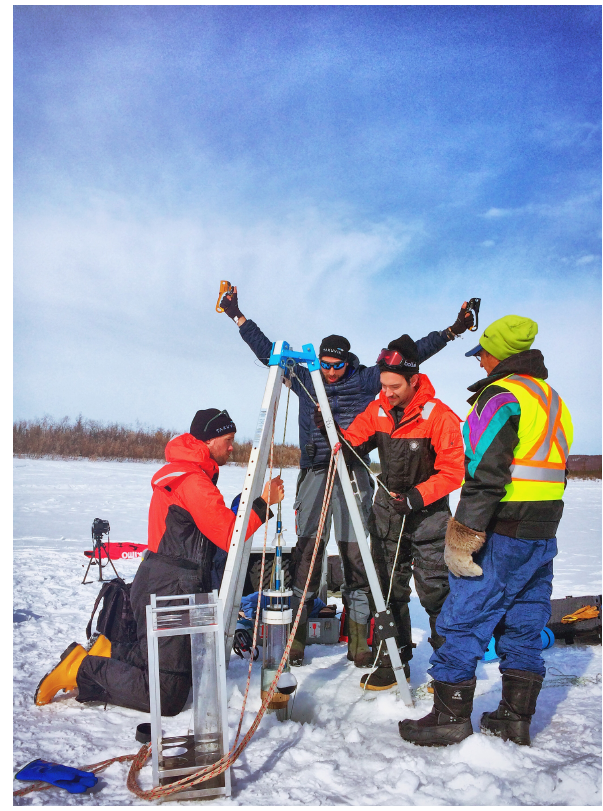
Figure E1. Picture taken during Leg 1 of the Nunataryuk expe- ditions showing the setup of the tripod and corer (picture credit: Martine